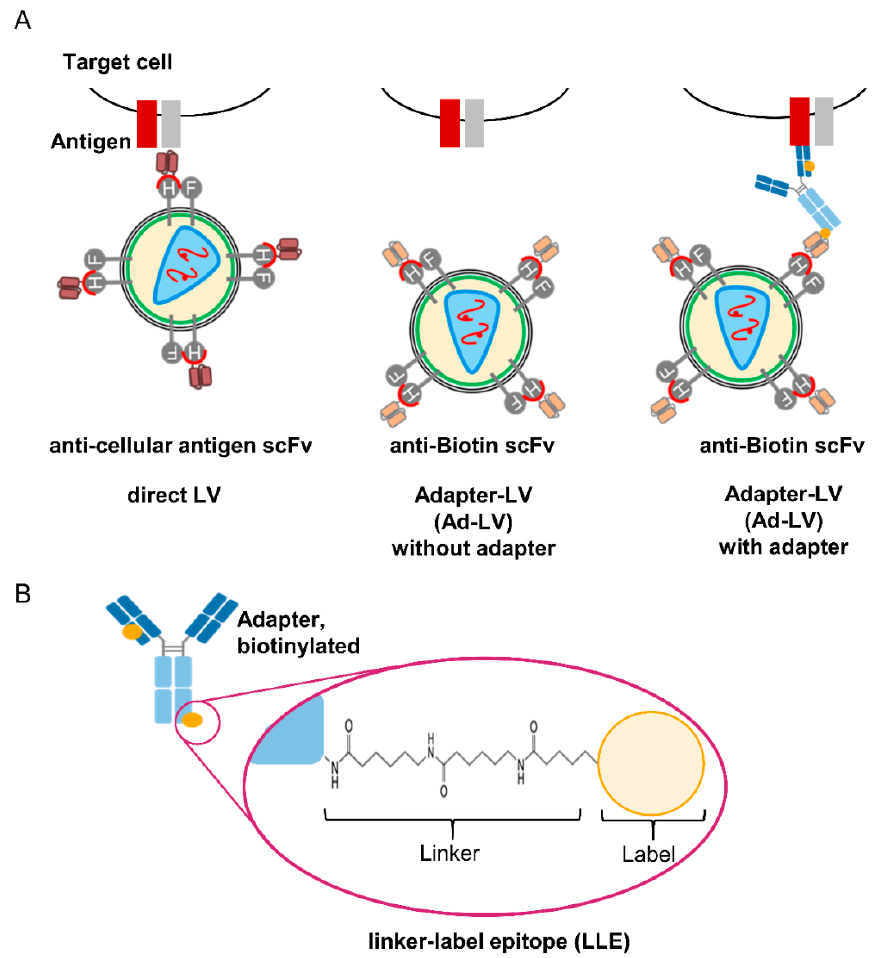
Figure 1. Concept of LLE adapter-mediated transduction with lentiviral vectors. ( A ) For directly targeted LVs, a binding ligand (e.g., scFv) is fused to the H protein of MV that is mutated to block natural receptor interactions. This allows specific entry to cells expressing the respective antigen (left). The adapter-mediated transduction is based on an scFv fused to the H protein of MV pseudo- typed LVs, which binds to biotin on a specific adapter molecule. In the absence of adapter molecules, transduction is abolished (middle). Only in the presence of a biotinylated adapter molecule trans- duction with the Adapter-LV (Ad-LV) is mediated (right). ( B ) Here, antibodies or antibody frag- ments were used as adapter molecules. The specific linker chemistry used for biotinylation gener- ates a linker moiety and a label moiety (biotin). The scFv used in this study interacts with the linked biotin (linker–label epitope, LLE) thereby avoiding recognition of free biotin. Only in the presence of a biotinylated adapter molecule Ad-LV particles bind and transduce the target cell. The target specificity is easily exchanged by variation in the adapter specificity, without the need of additional protein engineering. The linker chem- istry used for biotinylation results in adapter molecules that are composed of a linker moi- ety and a label moiety (biotin). The mBio3-18E7 scFv binds biotin in the context of the specific linker, referred to as the linker–label epitope (LLE) (Figure 1B) [23]. Consequently, unspecific binding to free or cell-bound biotin is avoided. The efficiency of pseudotyping correlates with the surface expression of the H protein in the producer cells [27]. Since initial experiments revealed a low surface expression of the designed protein, one critical residue was identified and converted to the murine germline consensus sequence, resulting in Ad-H(opt) [27]. Surface expression was ana- lyzed in the producer cells HEK293T transfected with the plasmid encoding the H protein fused to the original (Ad-H) or the optimized mBio3-18E7-derived scFv. Expression levels